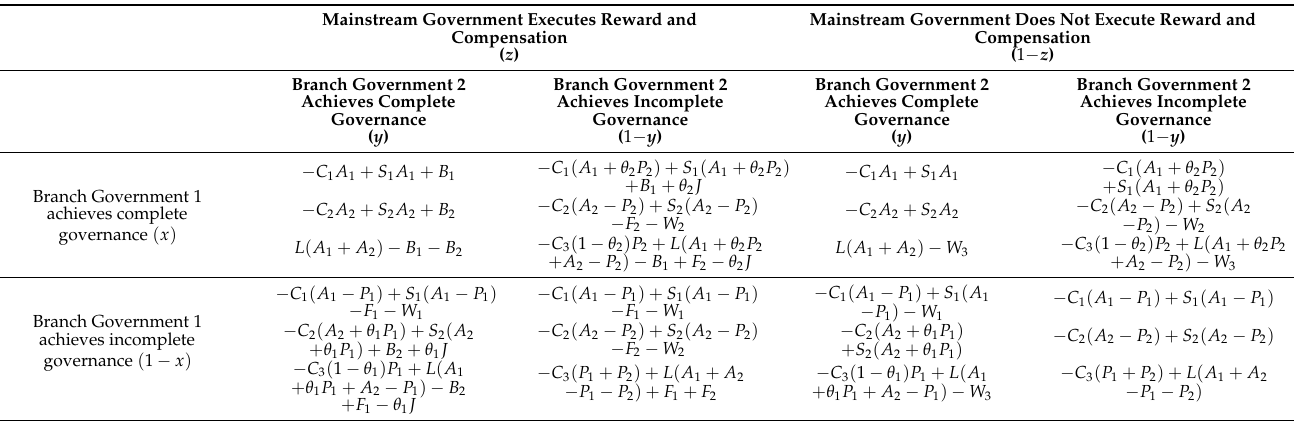
Table 2. Game benefit matrix among Mainstream Government, Branch Government 1 and Branch Government